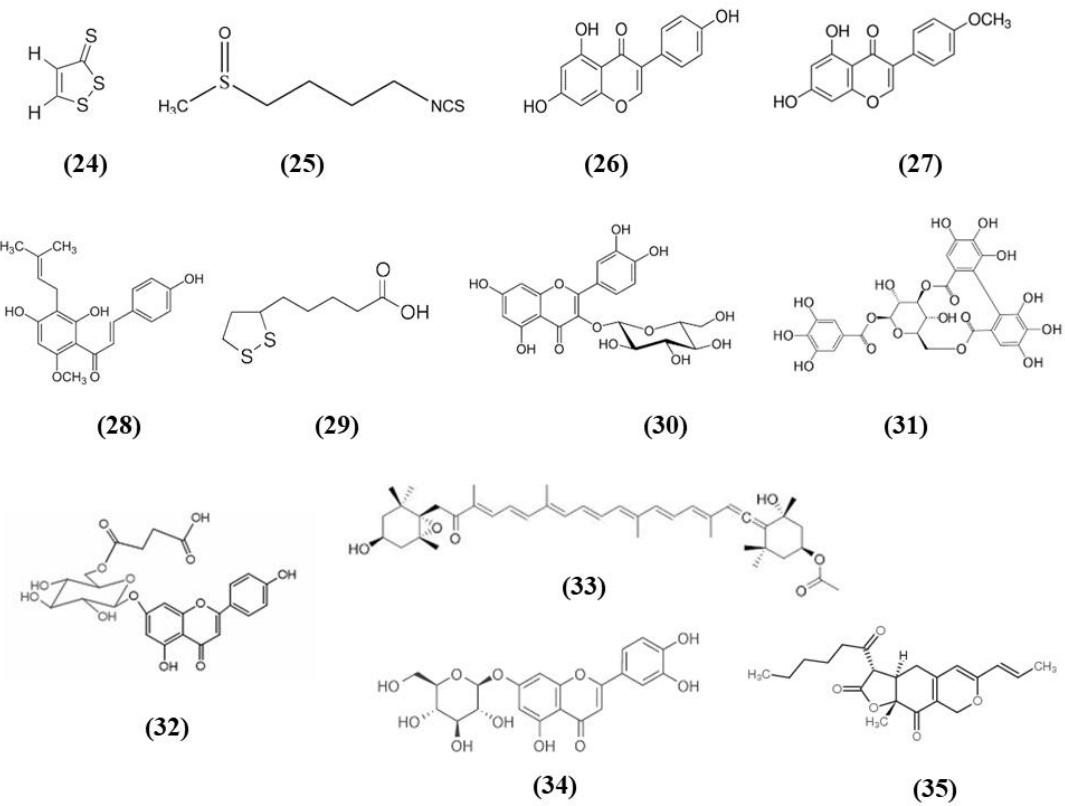
Figure 6. Chemical structure of ( 24 ) 3H-1,2-dithiole-3-thione, ( 25 ) sulforaphane, ( 26 ) genistein, ( 27 ) biochanin A, ( 28 ) xanthohumol, ( 29 ) α -lipoic acid, ( 30 ) isoquercetin, ( 31 ) corilagin, ( 32 ) 6''-O-succinylapigenin, ( 33 ) fucoxanthin, ( 34 ) luteoloside, and ( 35 )